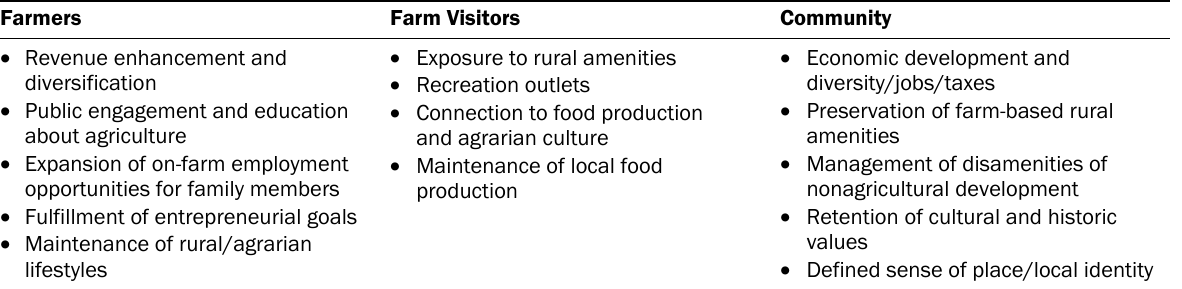
Table 3. Benefits of Agritourism